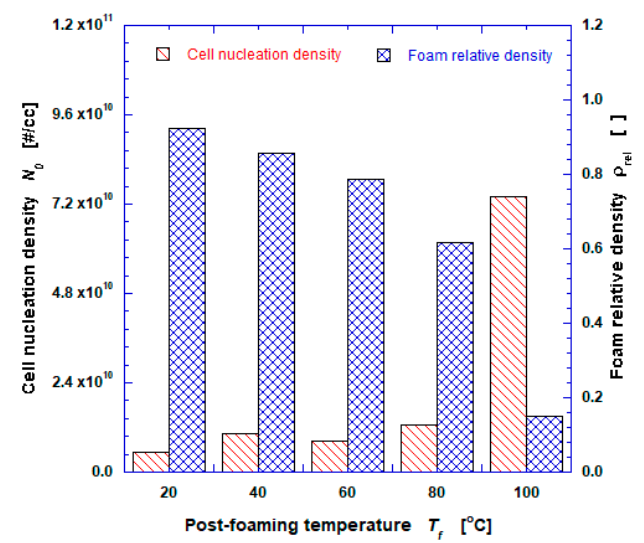
Figure 3. Effect of post-foaming temperature on cell nucleation density and relative density for the foamed copolymer filaments (sorption at 10 MPa and − 20 °C for 24 h).